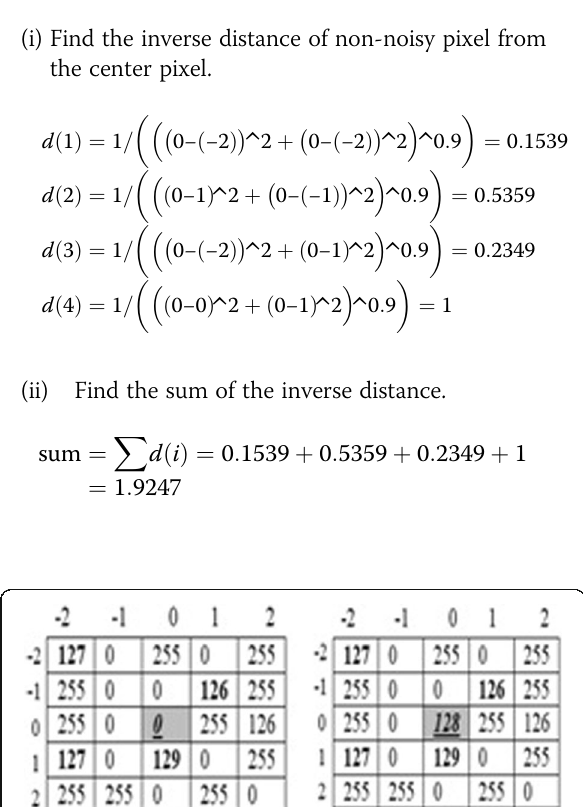
The corrupted pixel is replaced by 128 as shown in Fig. 4.